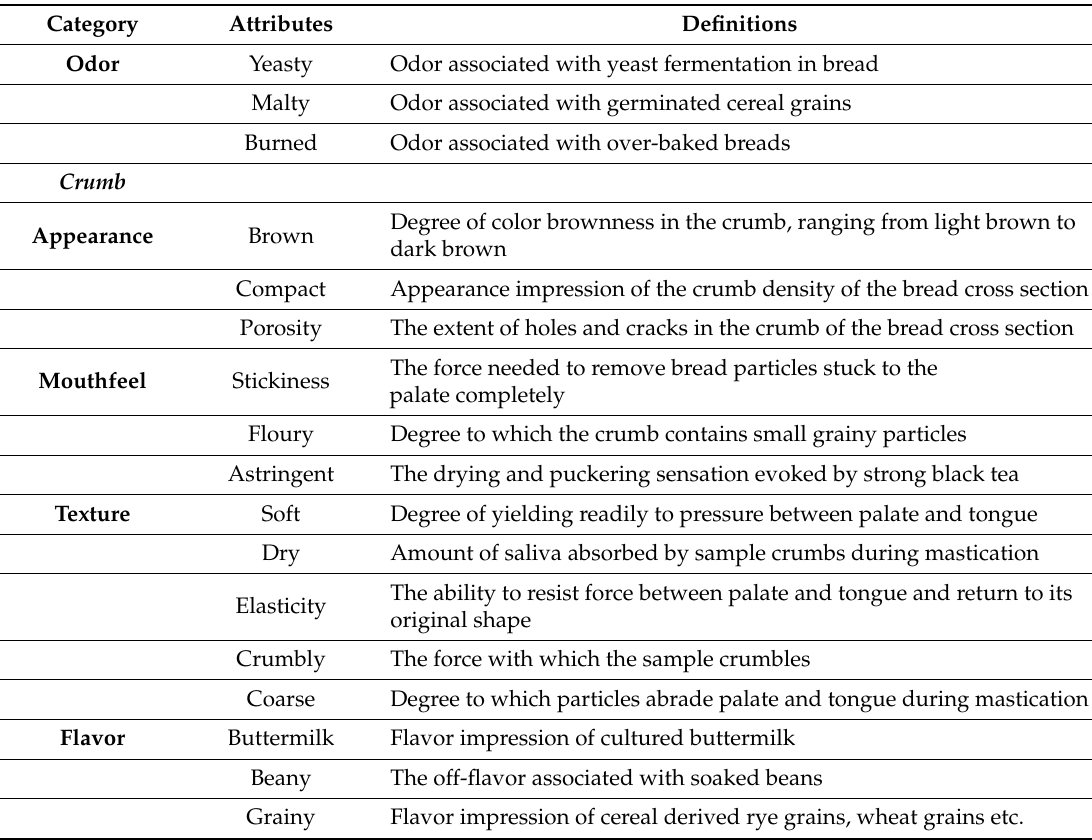
Table 2. Sensory attributes and corresponding definitions used in the descriptive analysis of rye breads.